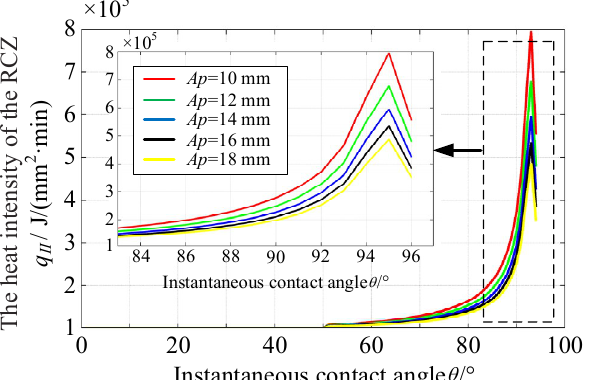
Figure 21. The heat intensity in the RCZ at different milling speeds ( Ap = 10 mm).